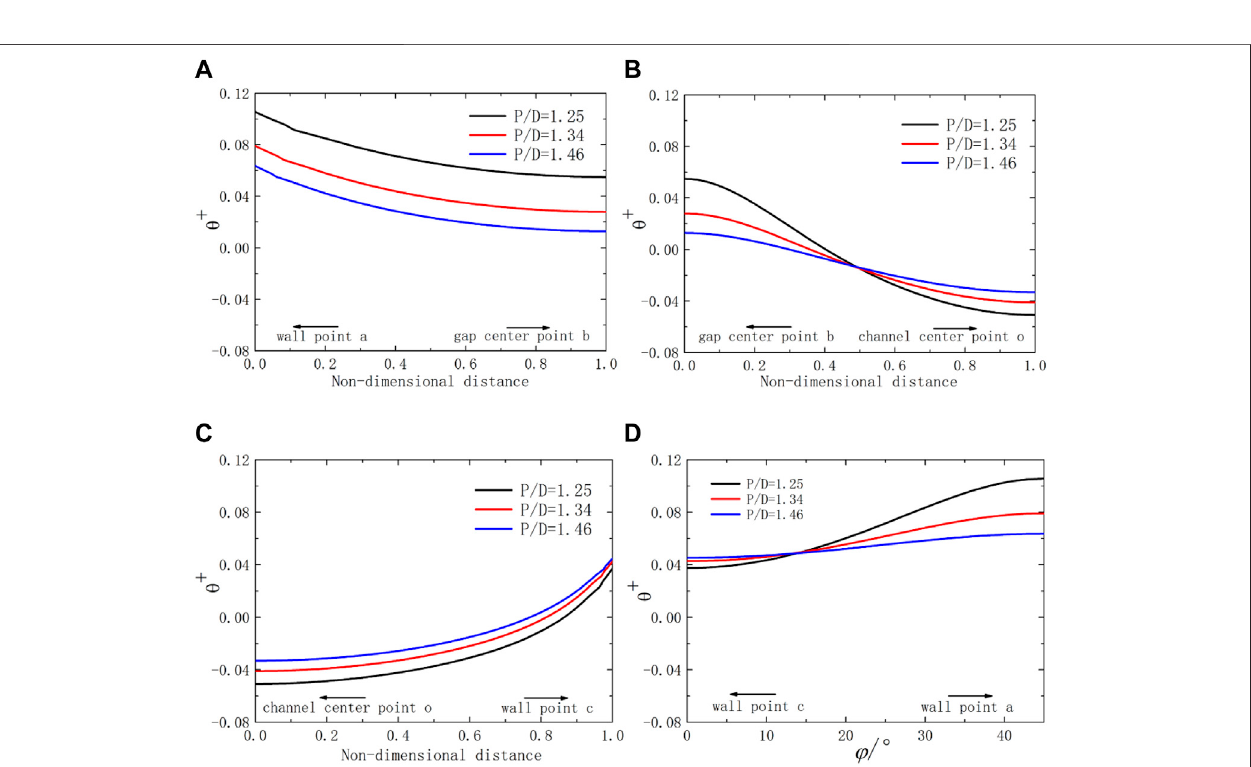
Frontiers in Energy Research |